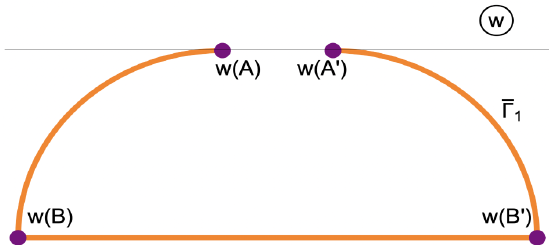
Figure 2. The complex w -plane with (pictorial) ¯Γ 1 in orange. w ( A 0 ) − w ( A ) = ¯ w ( A ) − ¯ w ( A 0 ) > 0 is fixed at ρ → + ∞ (the points w ( B ) and w ( B 0 ) are pushed to infinity).